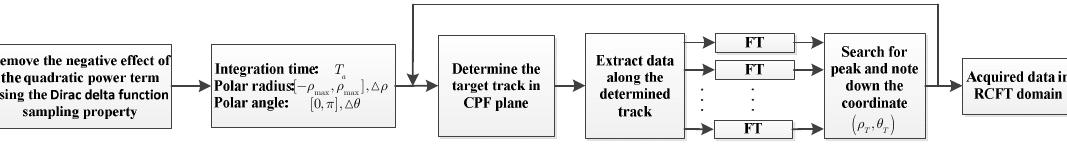
Figure 3. Detailed procedure of the proposed RCFT method.